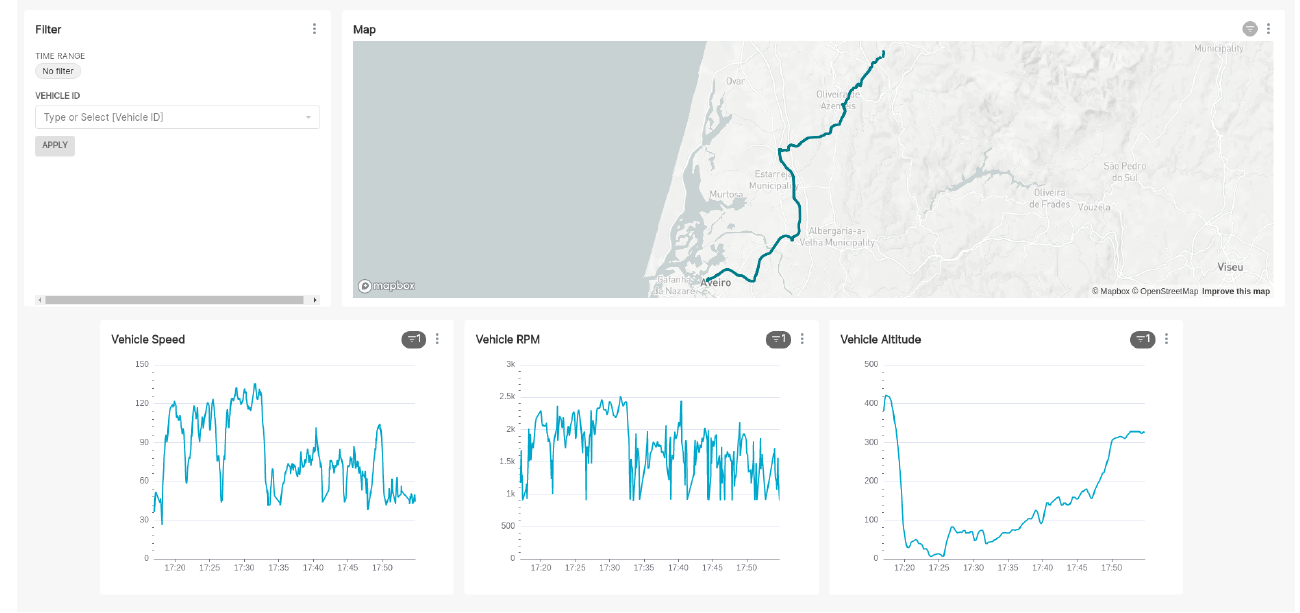
Figure 24. Web interface displaying the collected